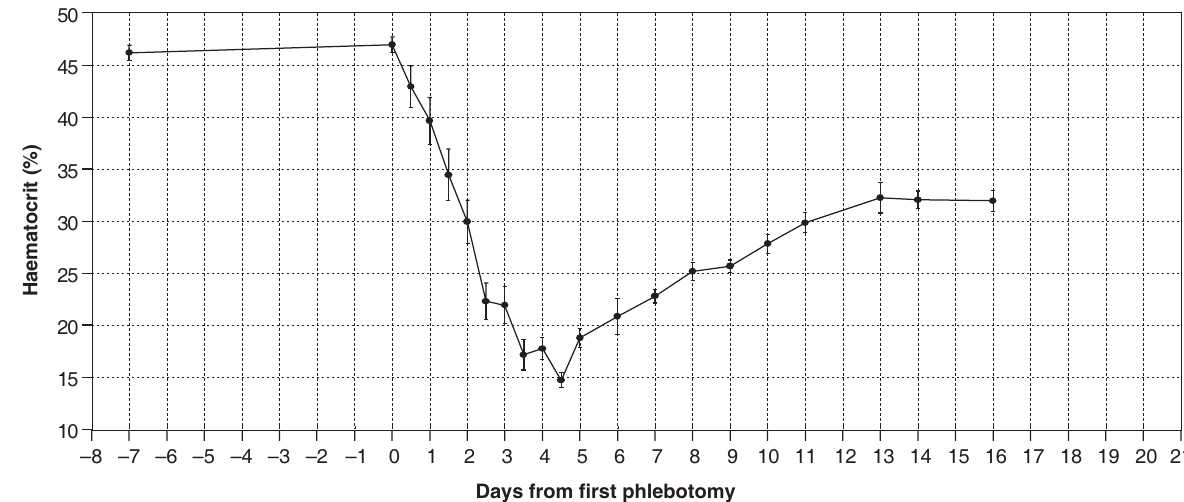
FIG. 1 The mean Ht value of all dogs measured on any particular day relative to the first phlebotomy being set as day 0. During the first 4 days Ht readings were often taken twice daily and the afternoon readings have been plotted as “half-days”. The pre-trial “screening” data were all assigned to day 7 for convenience, although some were conducted more than one week before the “active trial”. The error bars represent 2 SE on either side of the mean values